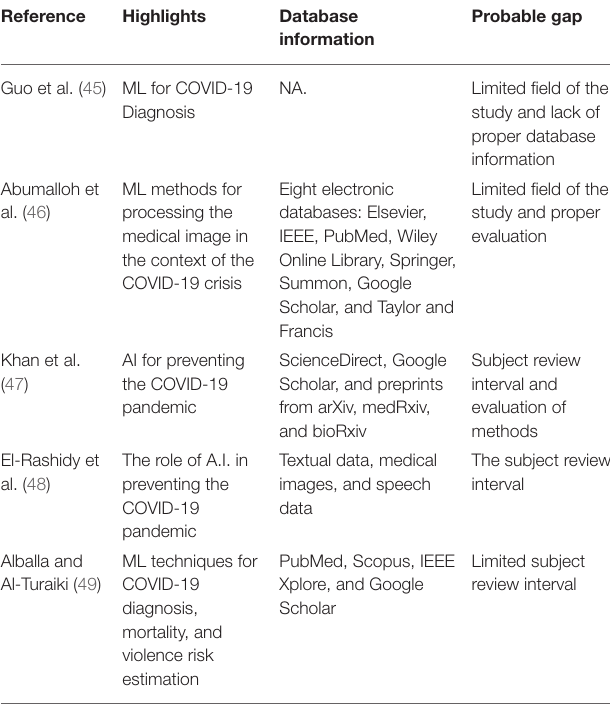
TABLE 1 | The description of the conducted review